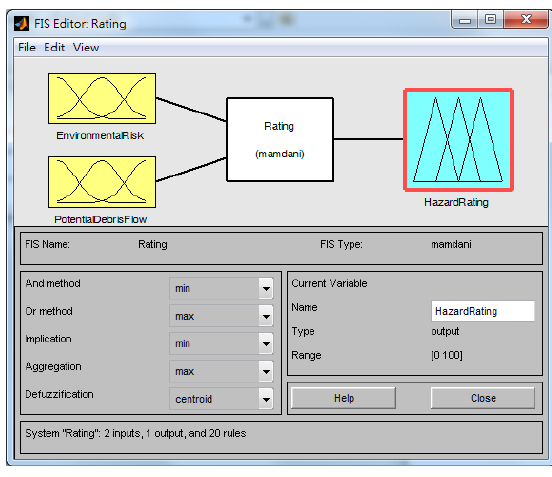
Figure 3. Fuzzy expert system for hazard rating.